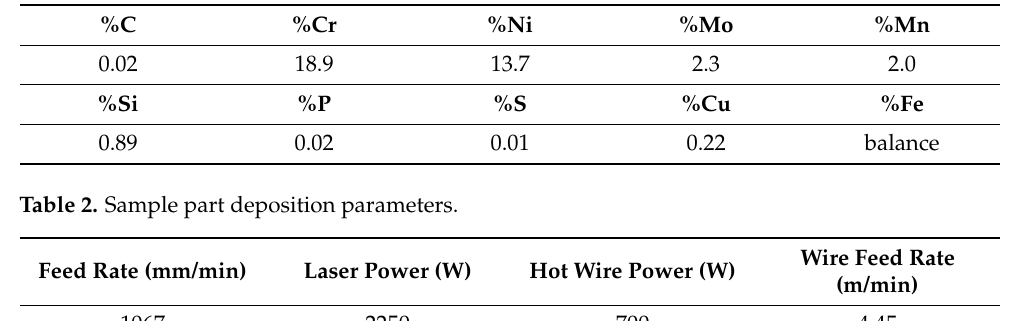
Table 1. Wire properties.